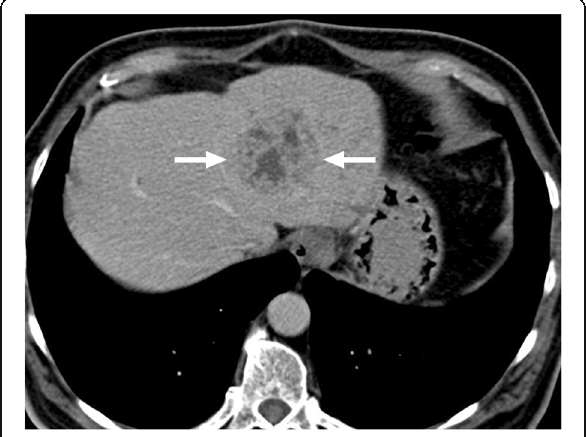
Fig. 7 A 70-year-old male with known colon cancer under complete remission underwent a routine screening CT examination. Axial plane postcontrast CT image revealed 5 cm predominantly solid mass (arrows) within the left liver lobe. The patient was completely afebrile and free of any abdominal pain at the time of the CT scan.